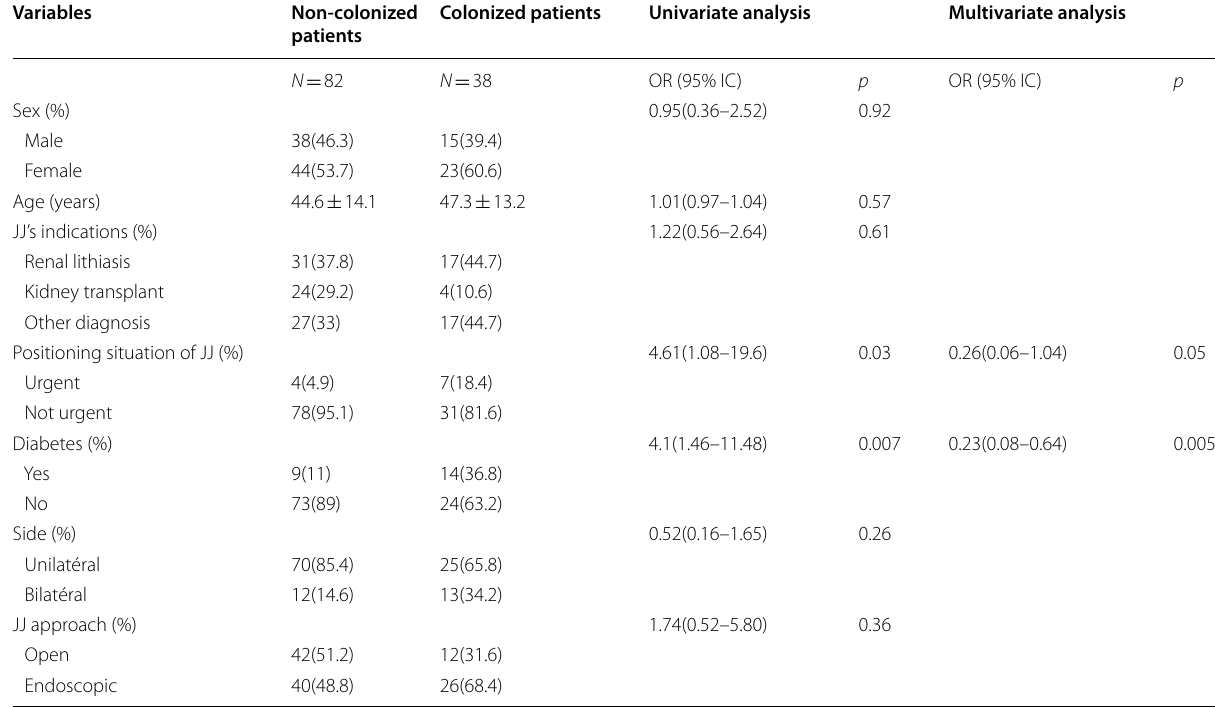
Table 1 Comparison of the both groups colonized and not in univariate and multivariate analyses Variables